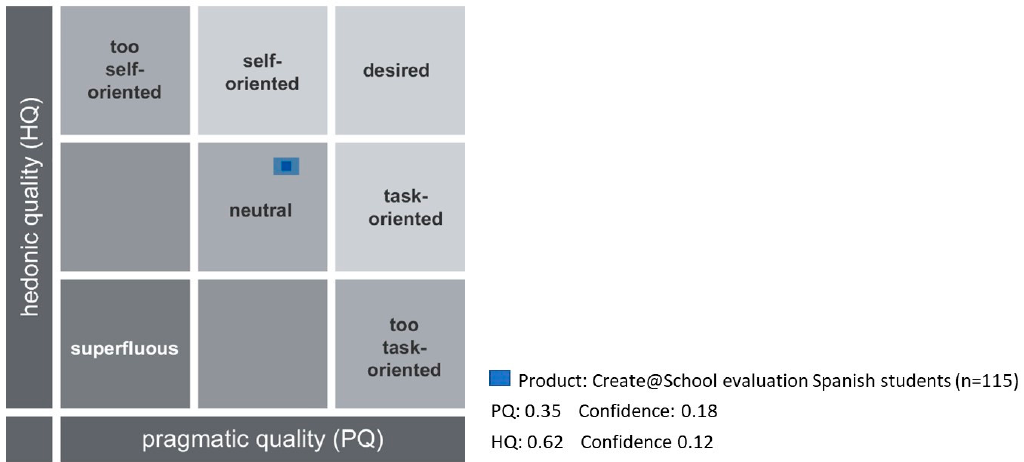
Figure 7. Overall evaluation of hedonic and pragmatic qualities for the study 3.2.3.